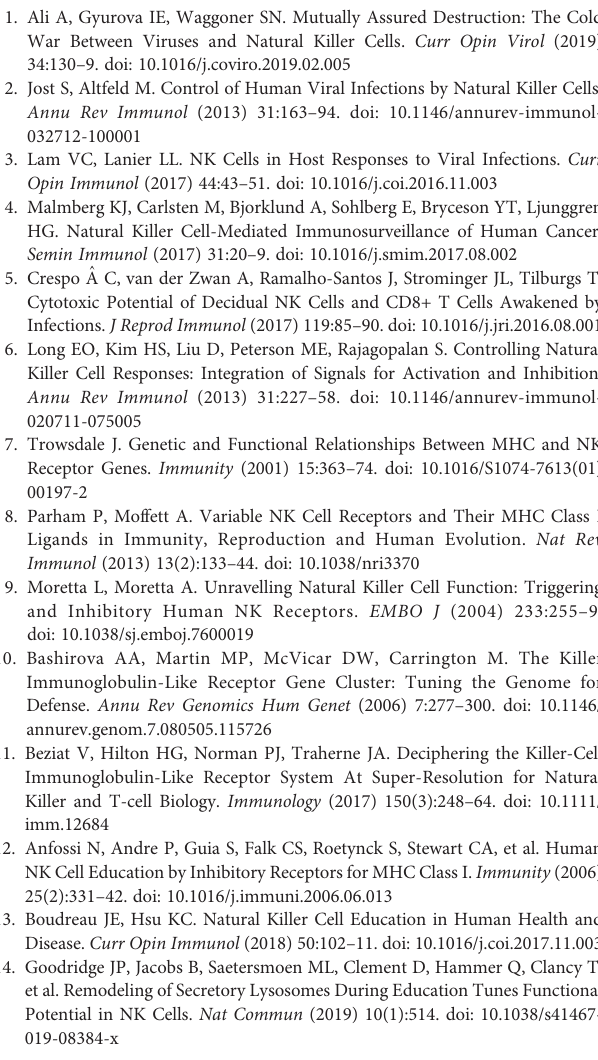
Figure 6A , and those expressing -21M are indicated with orange